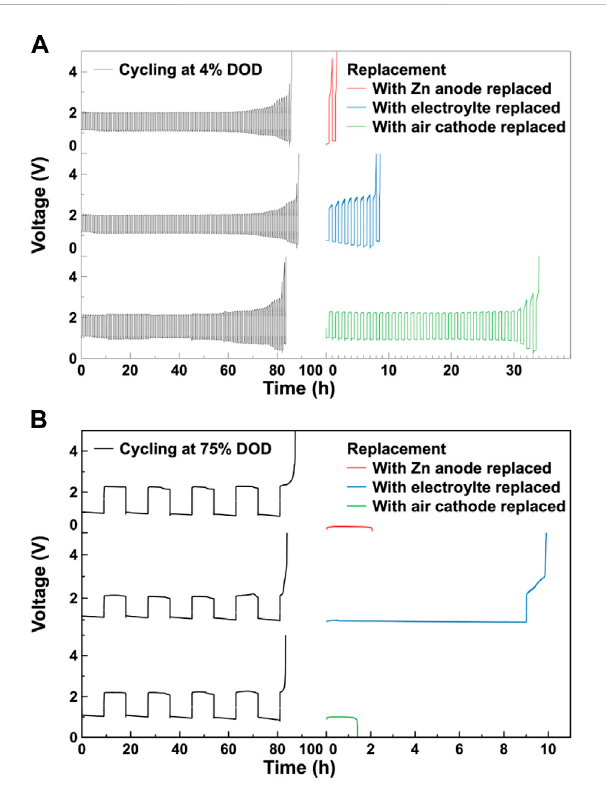
FIGURE 5 Replacement experiment. Galvanostatic charge/discharge cycle curves for ZABs and cycled ZABs with Zn anode, electrolyte and Co 3 O 4 / CB air cathode replaced, respectively at (A) 4% DOD and (B) 75% DOD,